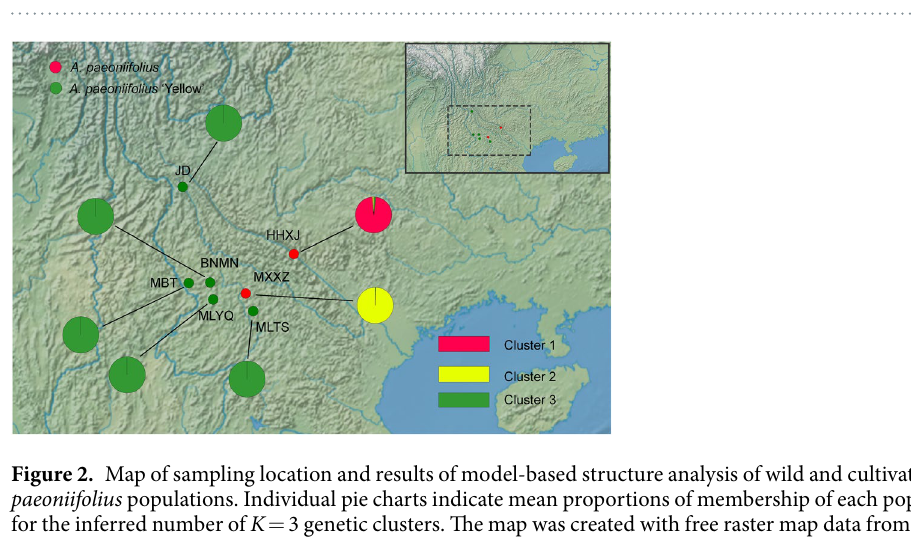
Table 1. The statistical values of genetic diversity within populations from variant and all positions data with p = 6/r = 0.8. ( A P , private allele number; H O , observed heterozygosity; H E , expected heterozygosity; π , nucleotide diversity; F IS , inbreeding coefficient of an individual relative to the subpopulation).